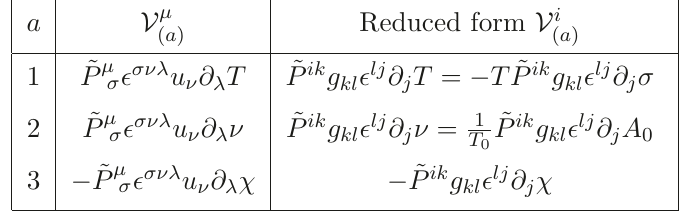
Table 2 . Parity-odd vectors in 2 + 1 dimensions and their dimensional reduction. Here we have i on the time circle, we find ( ) 0 = 0 while is specified in the right column. Also, after the ( a ) V ( a ) V reduction, the tangential projector takes the form ˜ P ij = g ij